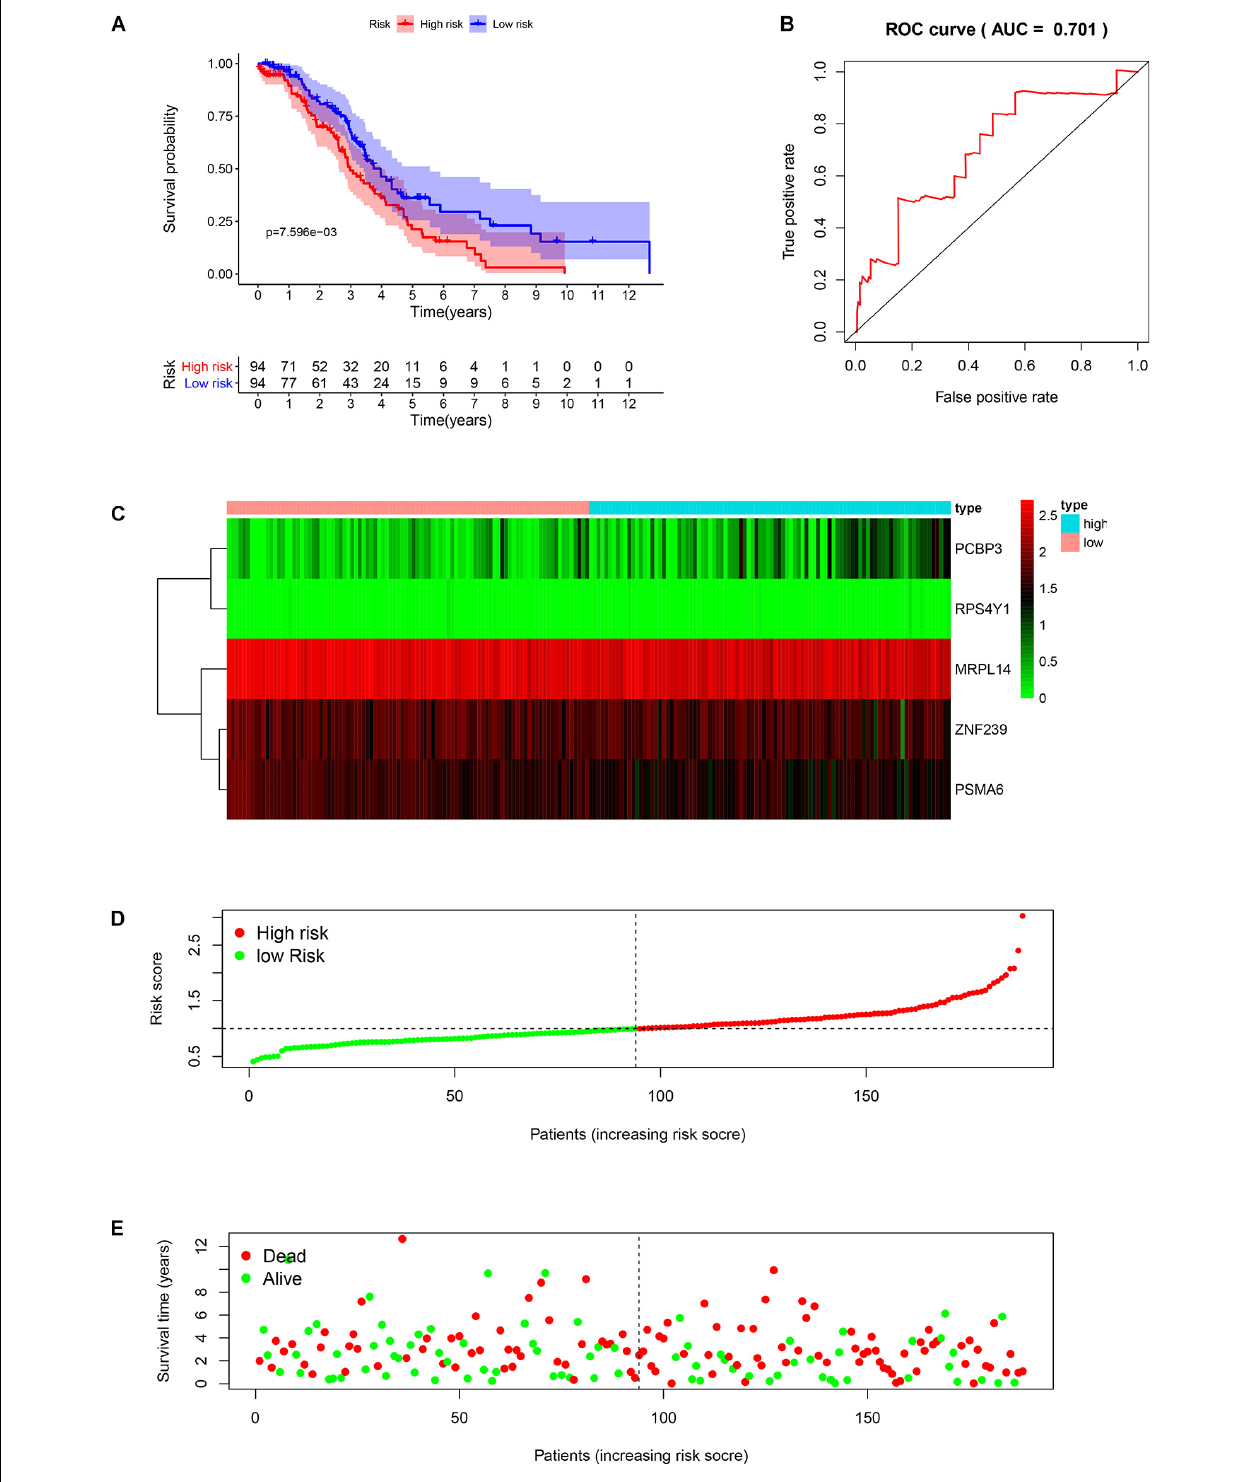
FIGURE 6 | Risk score analysis of the training cohort in TCGA using the 5-gene prognostic model. (A) Survival curve for low- and high-risk subgroups. (B) ROC curve for predicting OS based on risk score. (C) Expression heat map. (D) Risk score distribution. Patients were assigned to the training group based on risk score for determination of median risk score. (E) Survival status. The dashed line represents the median risk score; most patients on the right side had died, revealing a trend of greater risk of death with increasing risk score.